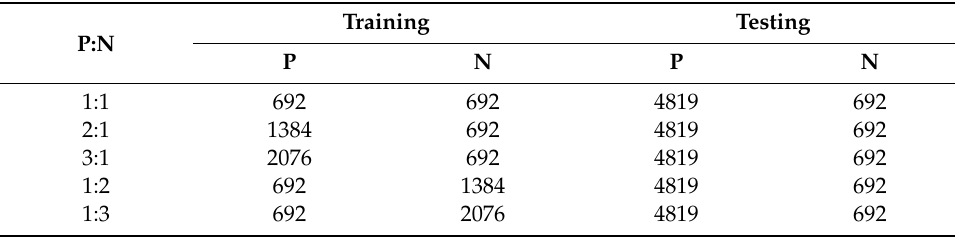
Table 1. Test sets with redundancy.